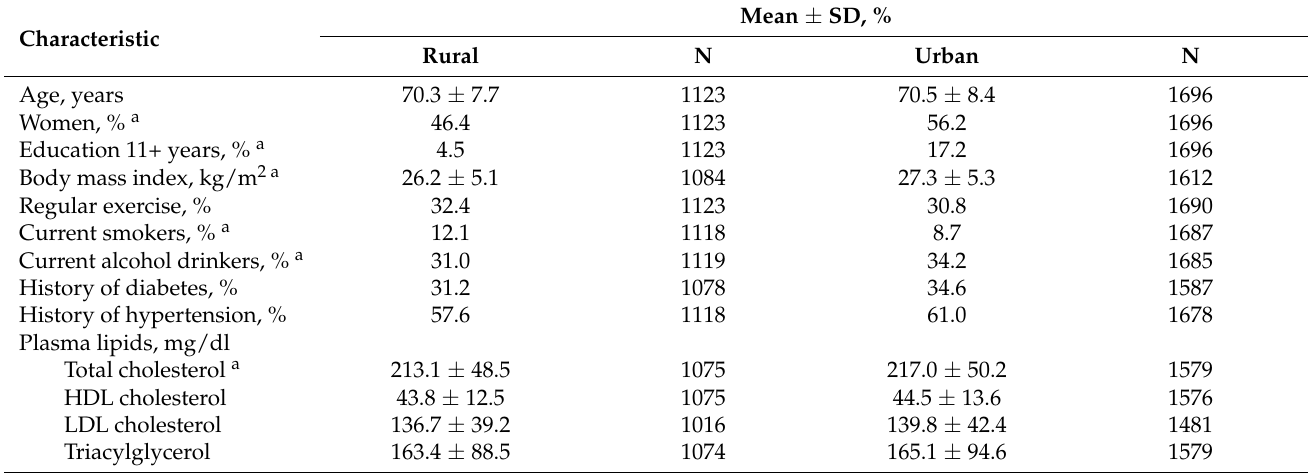
Table 1. Characteristics of CRELES participants: overall and according to place of residence.